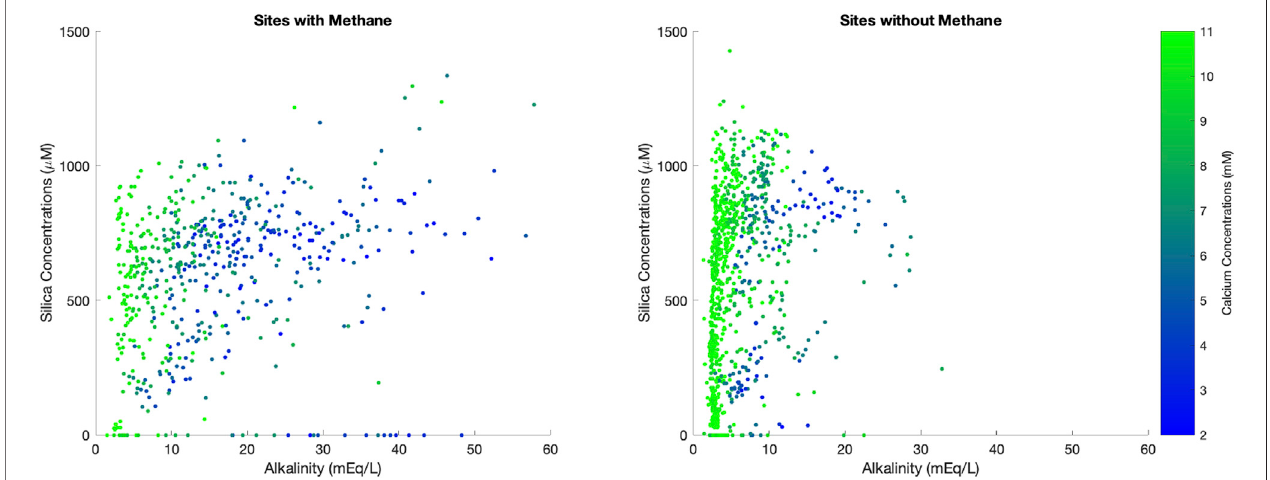
FIGURE6| Pore fl uidsilicaconcentrationsvs.pore fl uidalkalinity,shadedasafunctionofcalciumconcentrations.Dataaresplitintosedimentthathasmethanevs. sediment that does not.